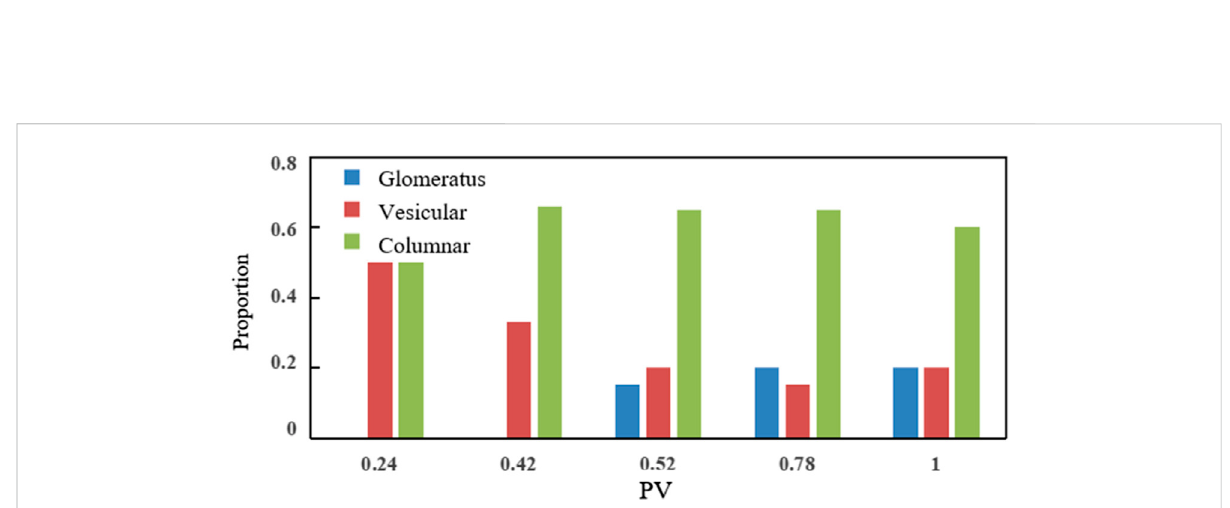
FIGURE 14 Distribution of residual oil types in the vertical fracture main line